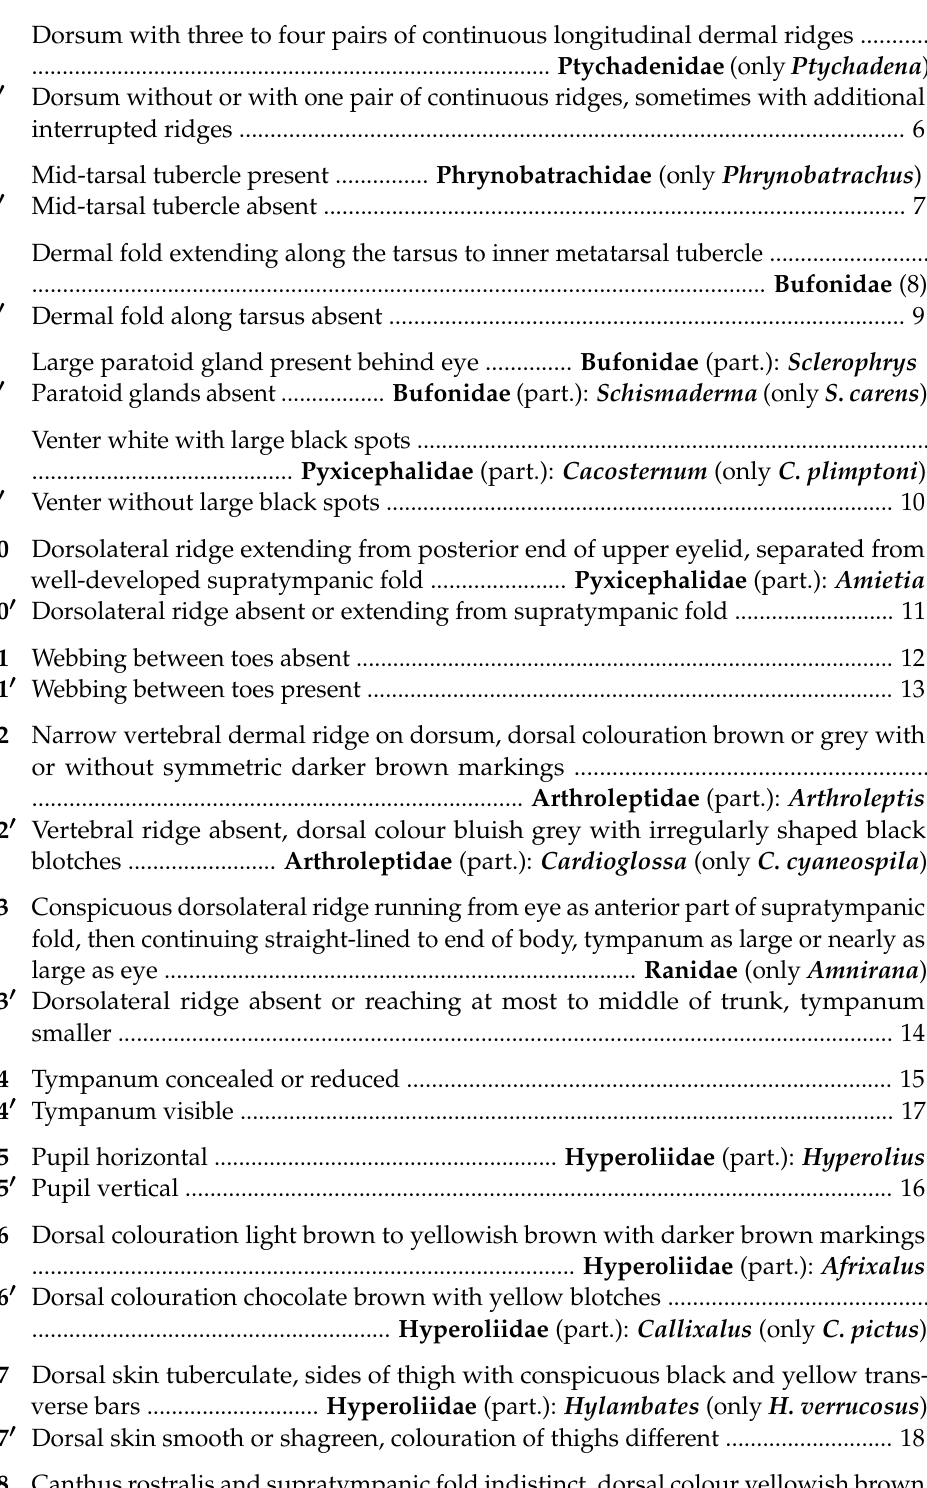
18 (cid:48) Canthus rostralis and supratympanic fold distinctly visible, dorsal colour